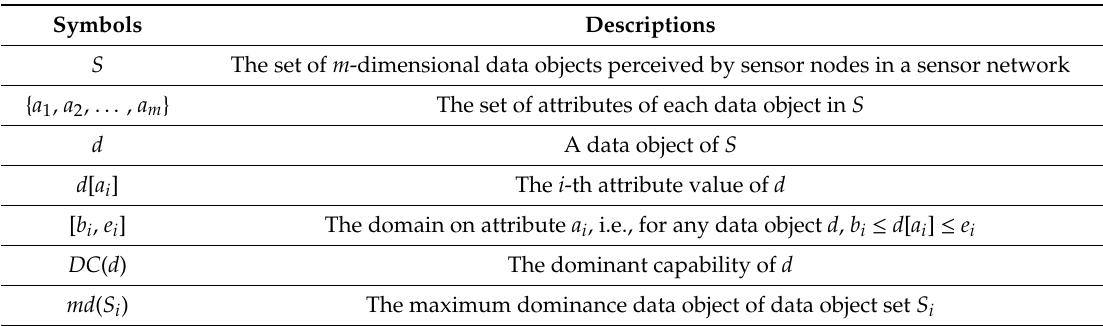
Table 2. Symbols used in this